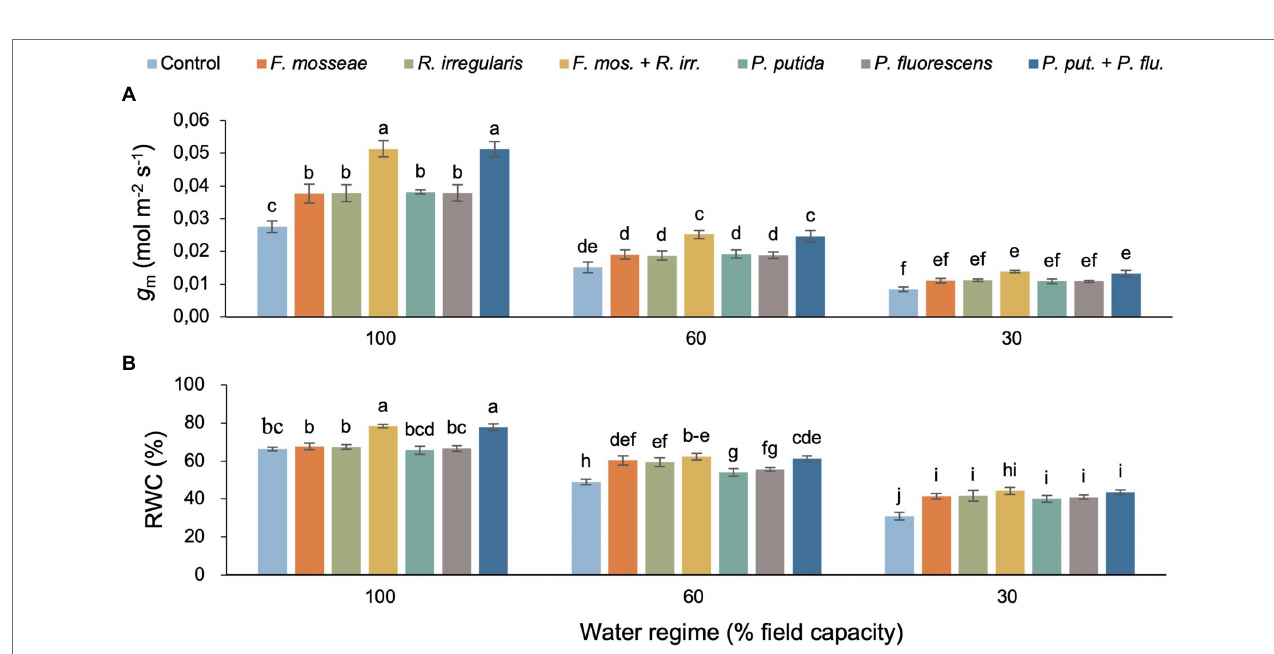
FIGURE 3 | The interaction effect of water regime and soil microbial inoculation on the mesophyll conductance ( g m ; A ) and relative water content (RWC; B ) of M. communis seedlings. For both variables, there was a significant water regime × inoculation treatment interaction. Different lower-case letters thus indicate significant differences between microbial inoculation treatments across water regimes (Duncan’s new multiple range test, α = 0.05).